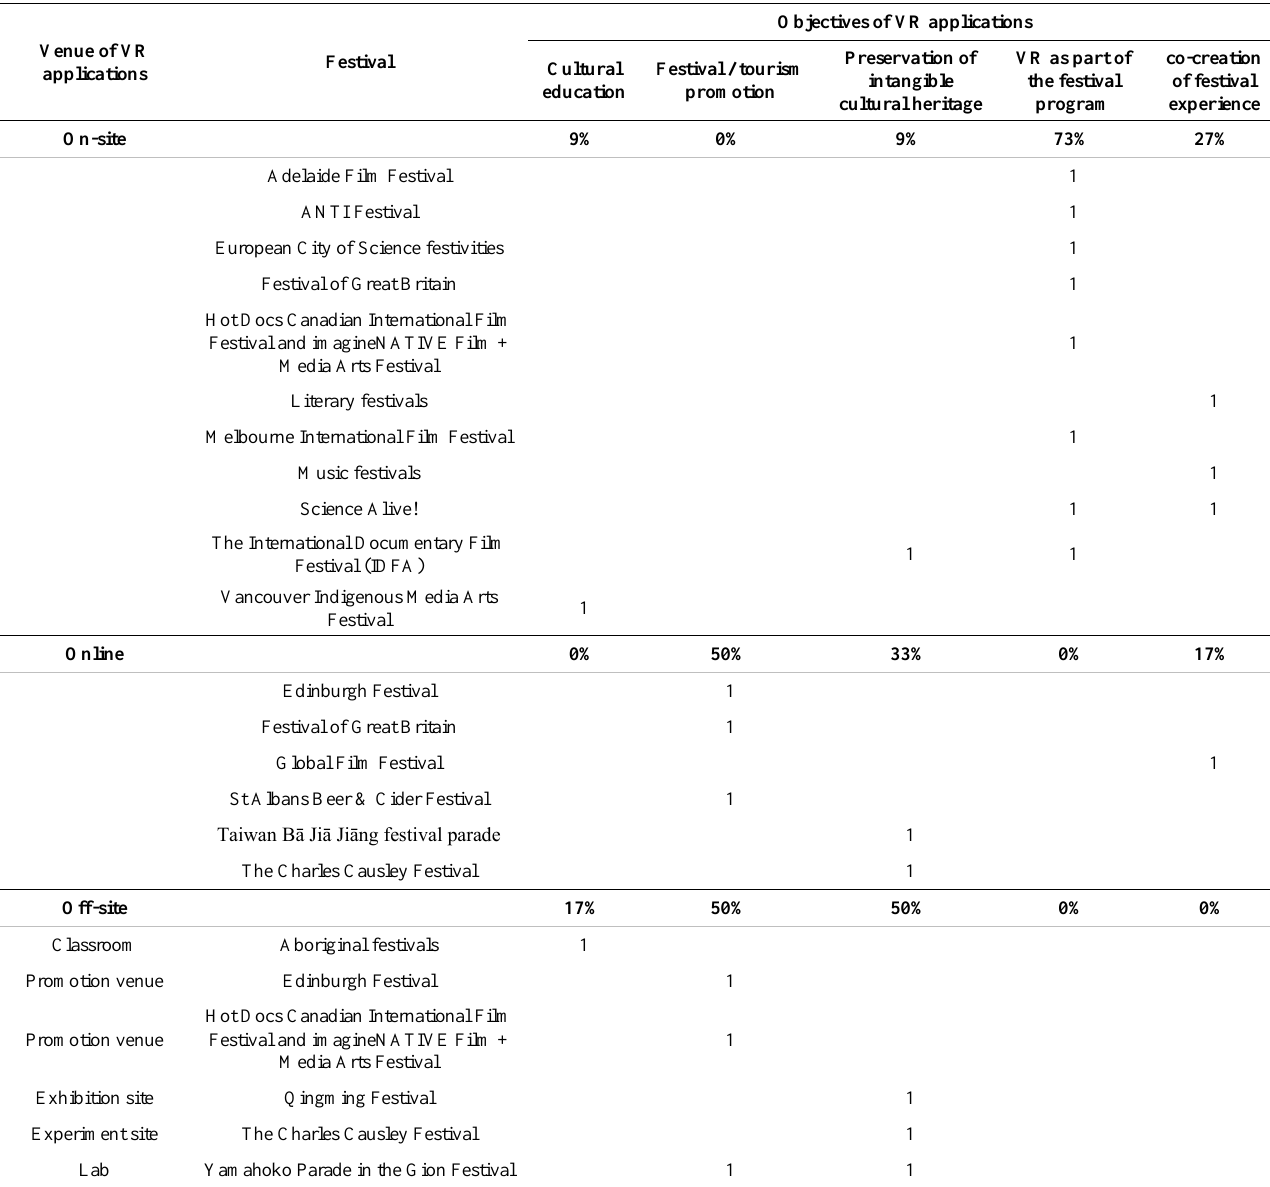
Table 6. Objectives of VR